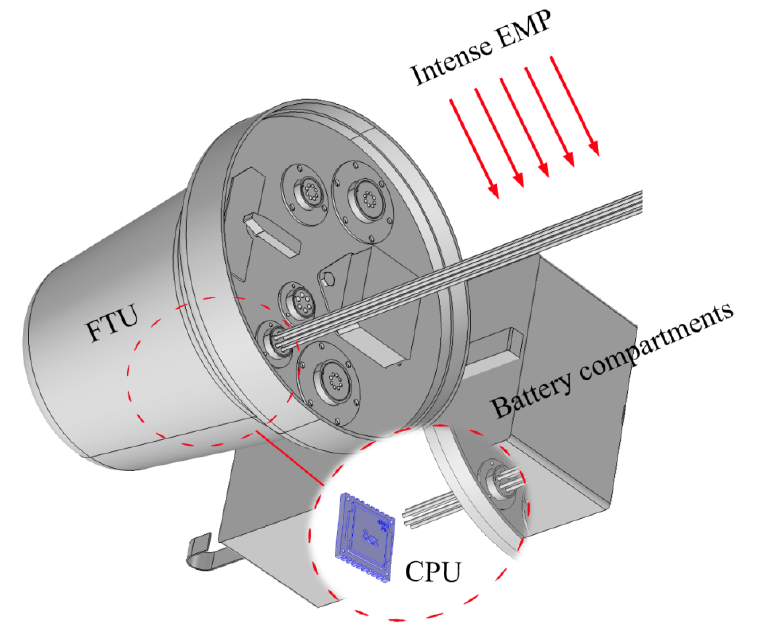
Figure 1. An intense EMP impacts on the FTU